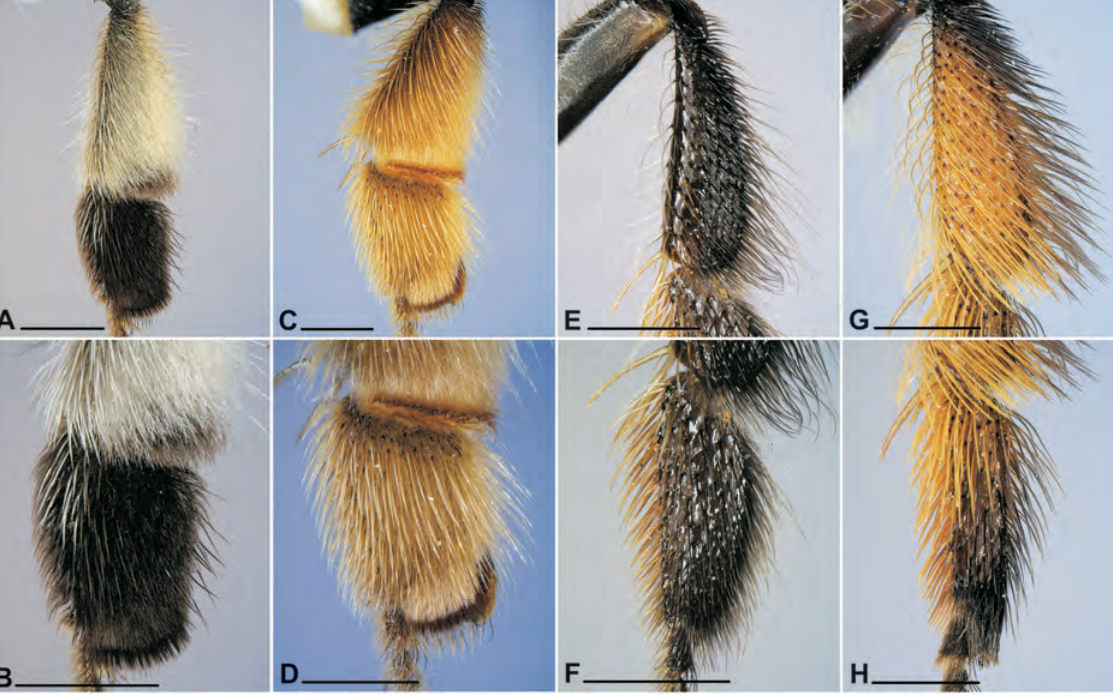
Fig. 1. — A-B . Macropis europaea Warncke, 1973, ♀. A. Hind leg, dorsal view. B. Hind basitarsus, dorsal view. — C-D . Rediviva intermixta (Cockerell, 1934), ♀. C. Hind leg, dorsal view. D. Hind basitarsus, dorsal view. — E-F . Redivivoides capensis sp. nov., ♀. E. Hind tibia, dorsal view. F. Hind basitarsus, dorsal view. — G-H . Melitta arrogans (Smith, 1879), ♀. G. Hind tibia, dorsal view. H. Hind basitarsus, dorsal view. Scale bar: 1